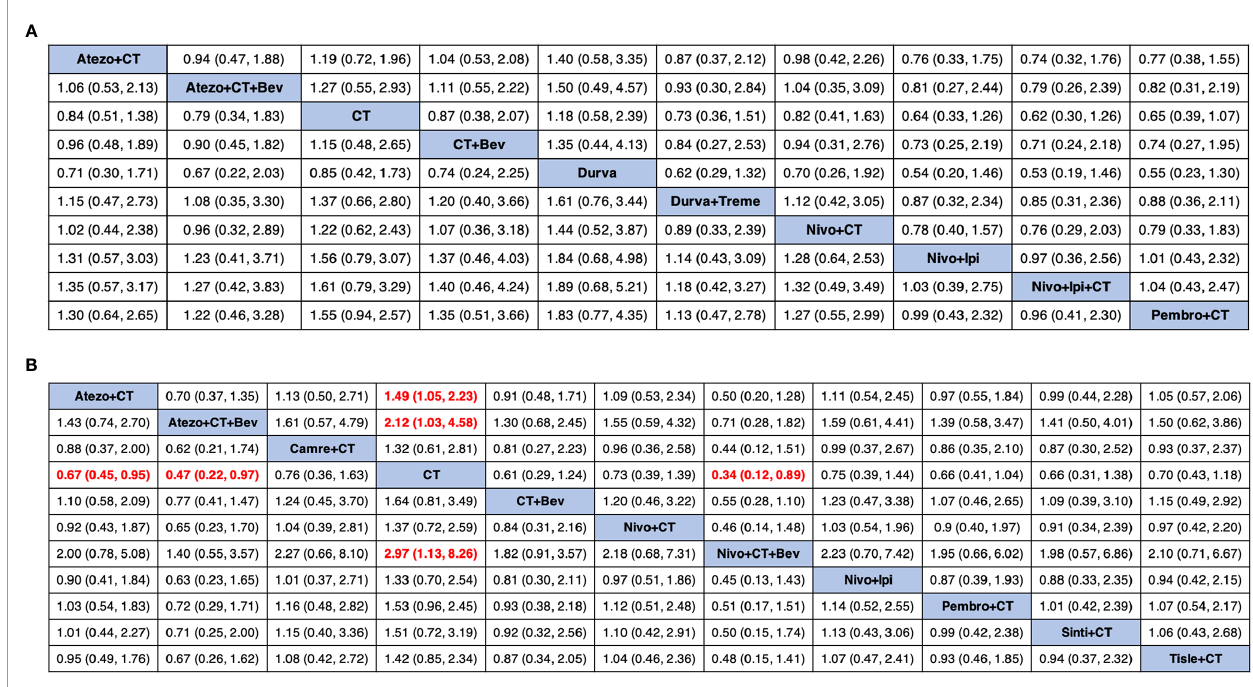
FIGURE 4 | Comparative ef fi cacy of treatments for OS (A) and PFS (B) in network meta-analysis. Comparisons should be read from left to right. HR (95% credible interval) for comparisons is in cells in common between column-de fi ning and row-de fi ning treatment. Bold cells are signi fi cant. HR >1 favors row-de fi ning treatment, and HR <1 favors column-de fi ning treatment. CT, chemotherapy; Atezo, atezolizumab; Bev, bevacizumab; Nivo, nivolumab; Ipi, ipilimumab; Pembro, pembrolizumab; Carem, caremlizumab; Durva, durvalumab; Treme, tremelimumab; Tisle, tislezumab; Sinti, sintilimab; NR, not